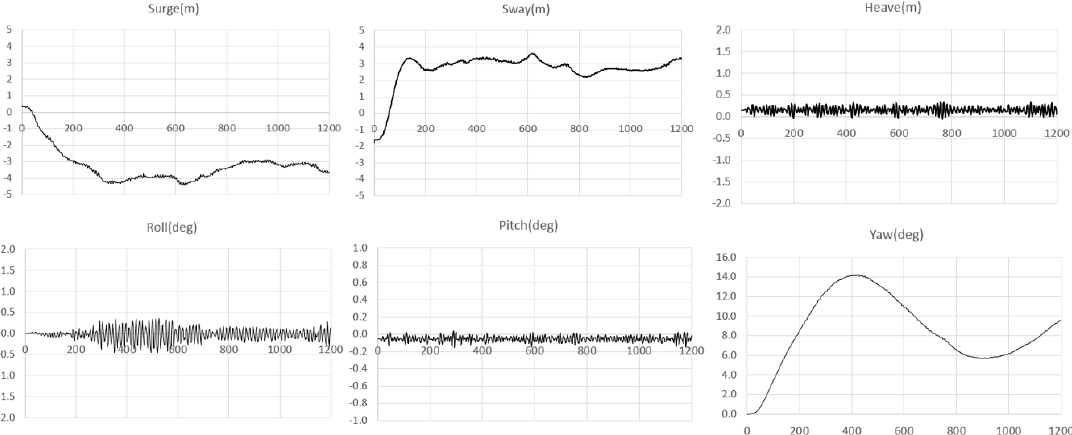
Figure 23. 6DOF Motions under GOM 1-Year Case.